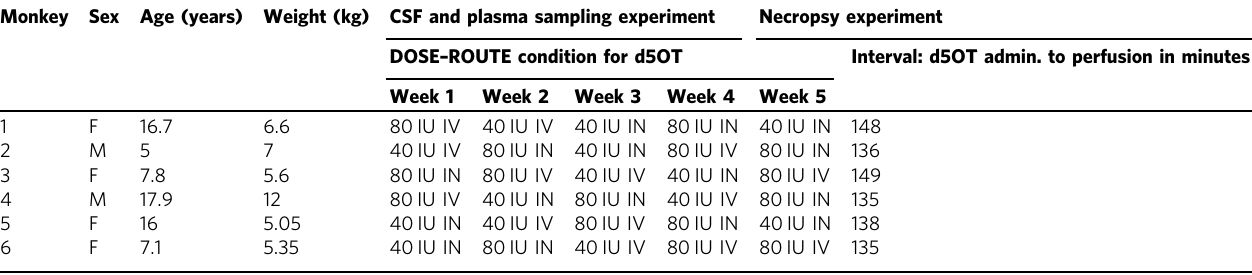
Table 4 Subject Characteristics and Experimental Details. Monkey Sex Age (years) Weight (kg) CSF and plasma sampling